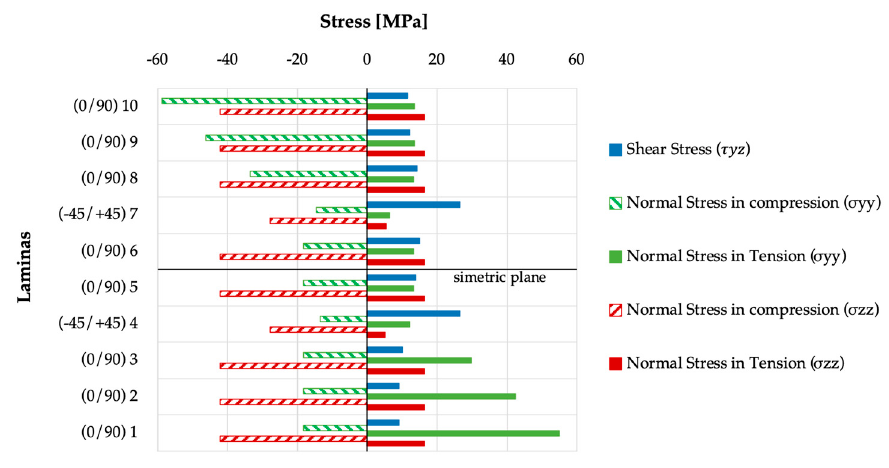
Figure 17. Stress results per layer in the BFRP component.